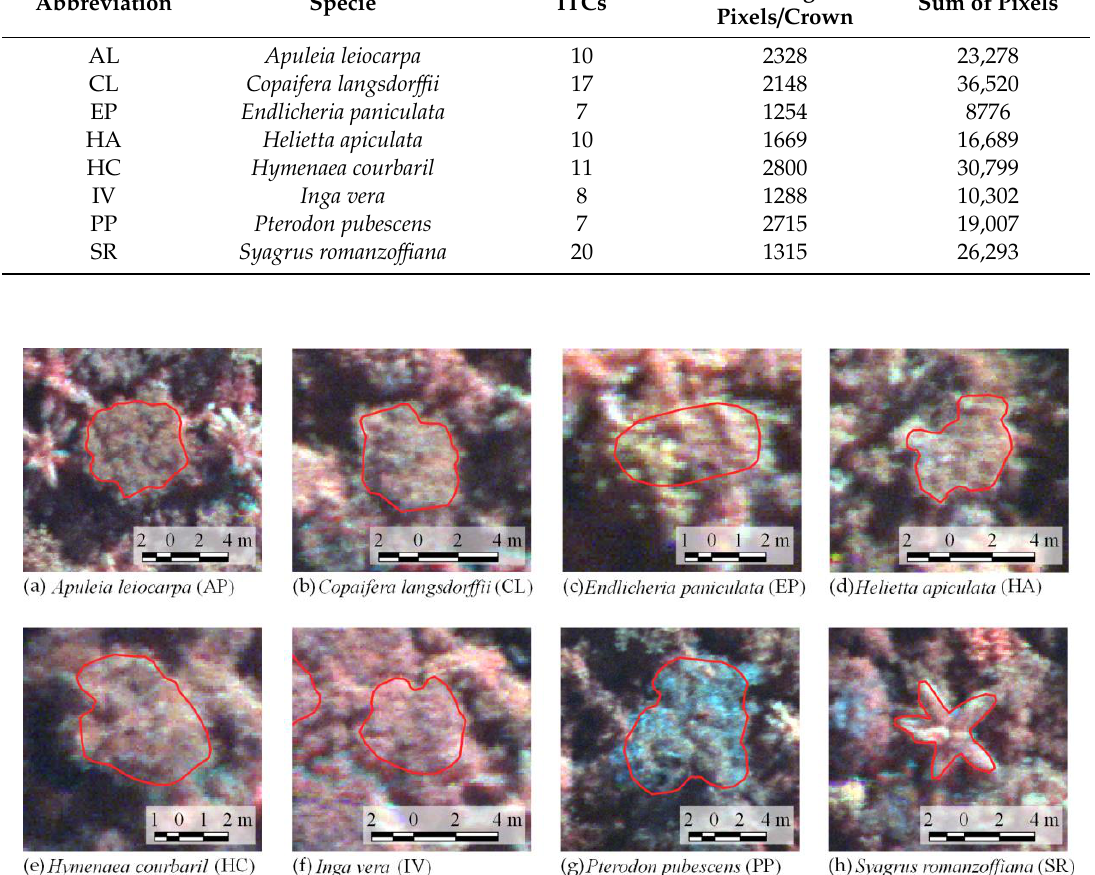
Figure 3. Canopy examples of each tree species identified in the field and delineated in the images acquired in 2017 (R: 780.49 nm; G: 565.10 nm; B: 506.22 nm; automatic contrast from QGIS software,